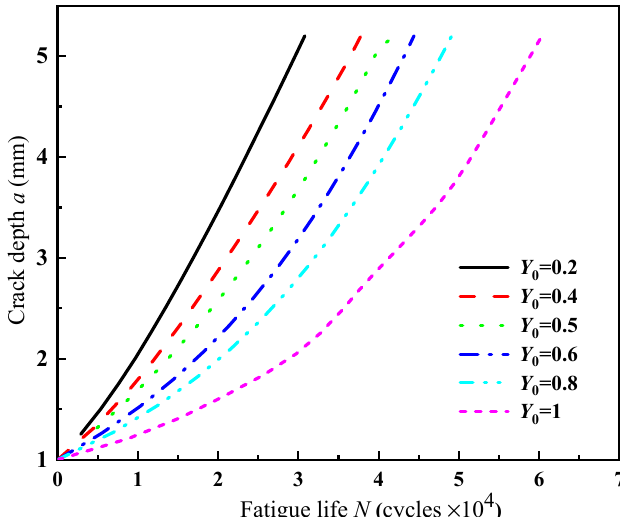
Figure 9. The a-N curve of initial crack growth with different shape ratios. Table 4. Crack growth results with different initial shape ratios.